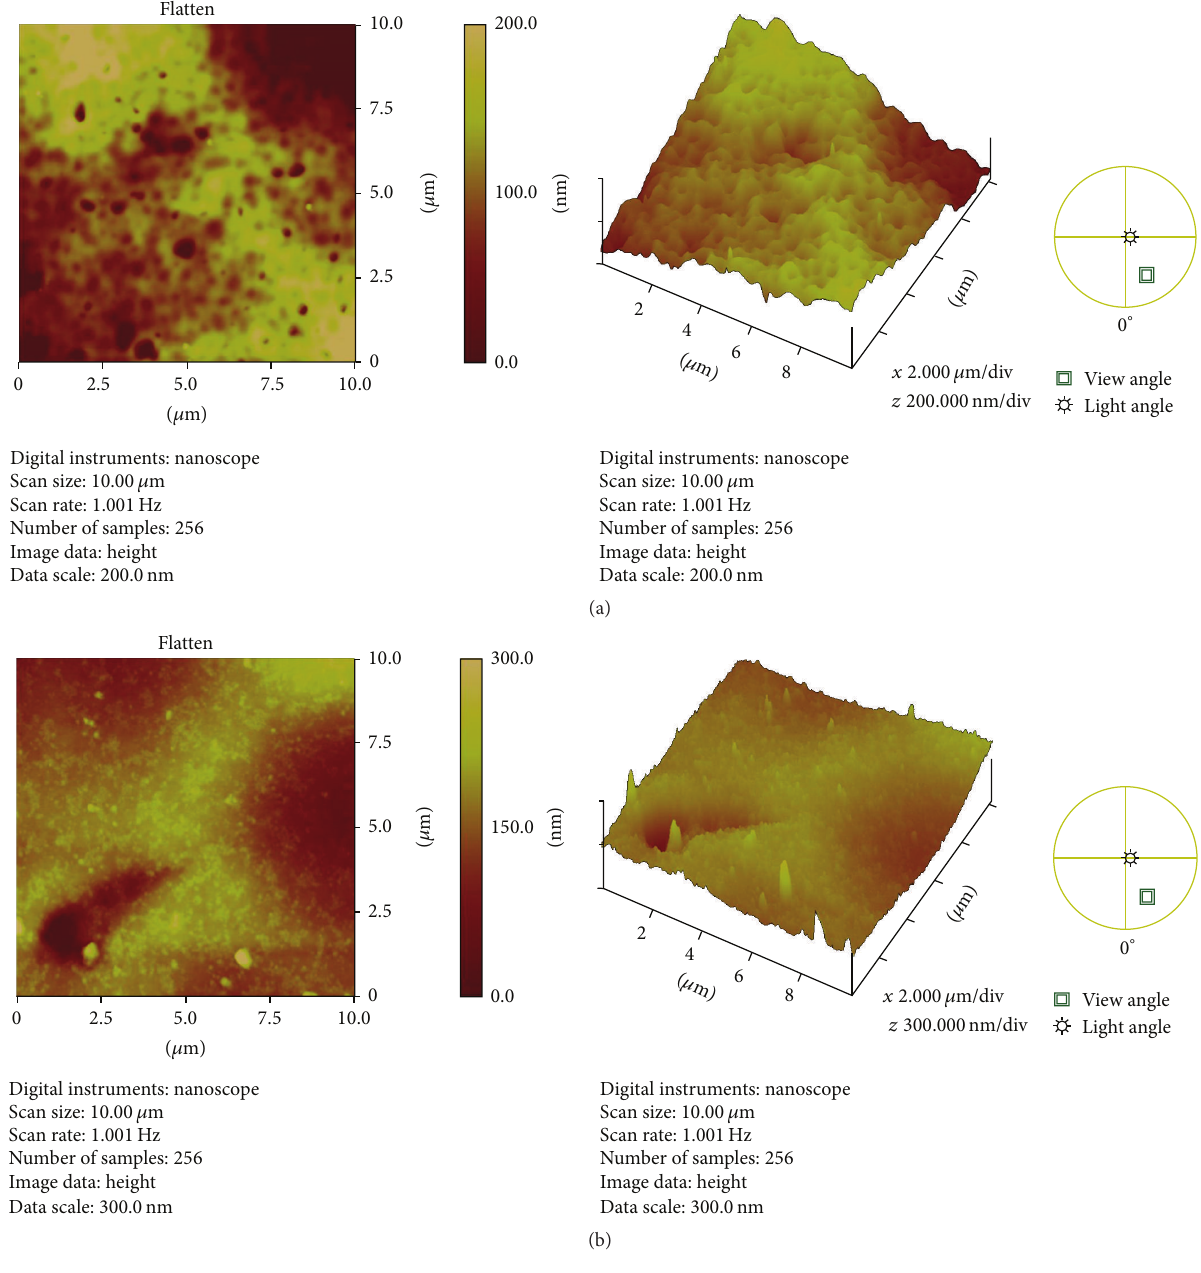
Figure 3: AFM images of (a) M-PES and (b) M-PAANa.